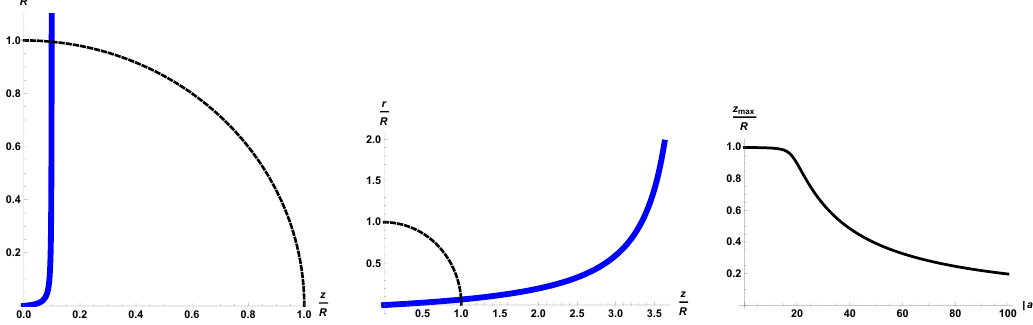
Figure 7 . Left: intersection of z 2 + r 2 = R 2 with the D3-brane embedding (thick, blue curve) for ~ (cid:20) = 0 : 1 and aR = (cid:0) 100. Centre: the same curves for ~ (cid:20) = 0 : 05 and aR = (cid:0) 5. Right: plot of